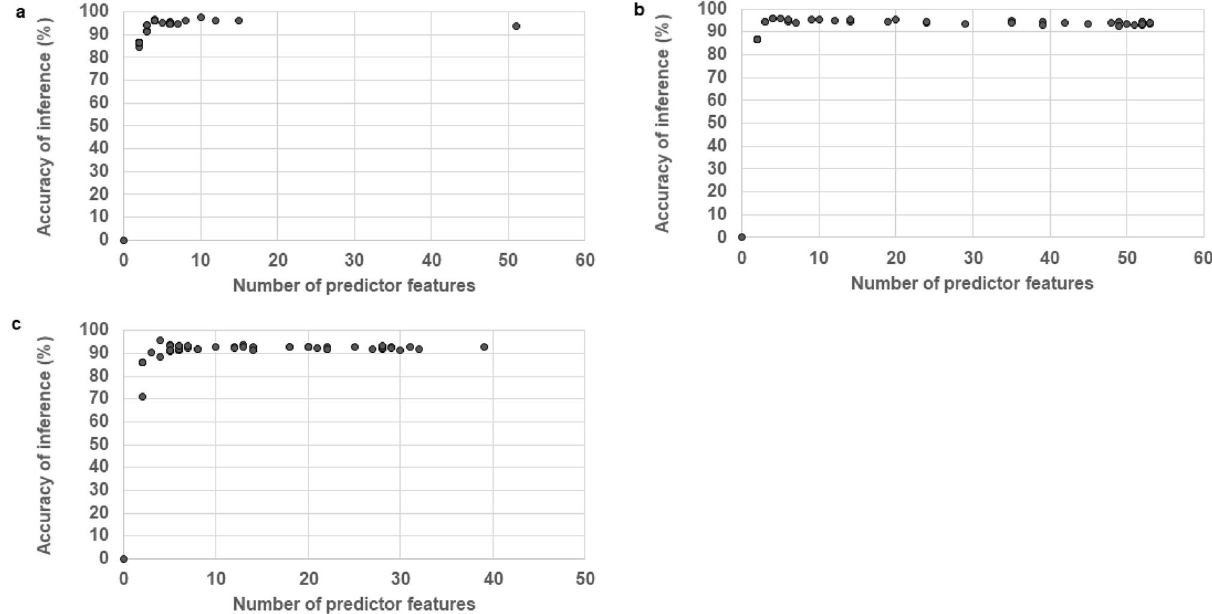
Figure 2. Susceptibility tests. The accuracy of inferring the group A Streptococcus emm -type by applying a different number of predictor features (response regulator alleles) to each of the three tested random forest classifiers [( a ) Guided, ( b ) Ordinary, and ( c )